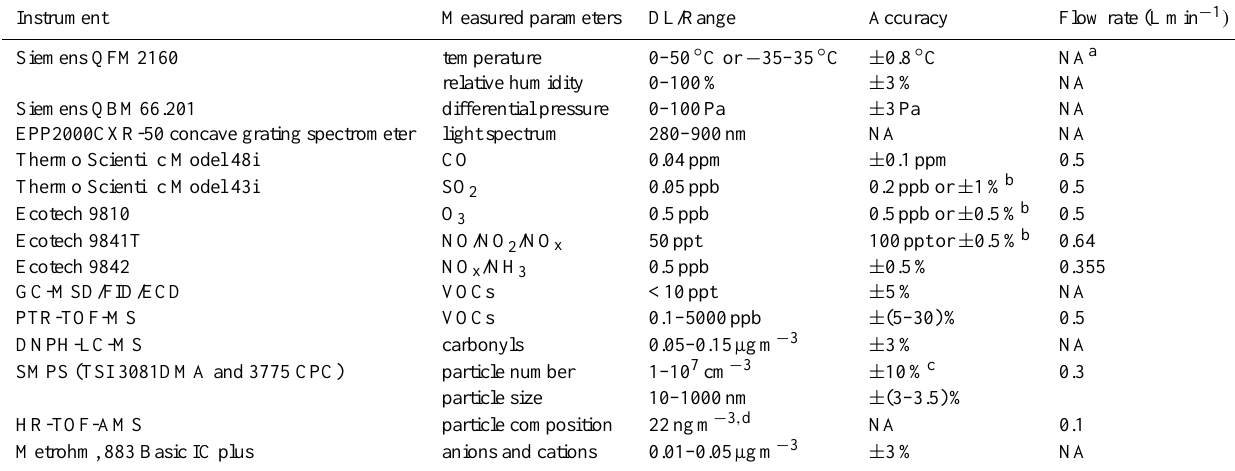
Table 1. Overview of